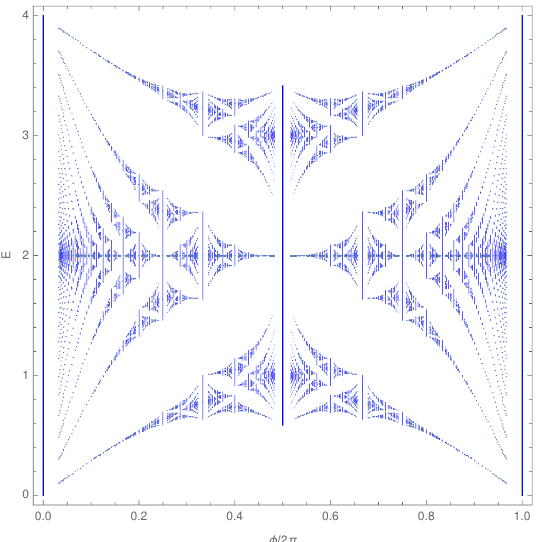
( N; (cid:30) ) with 0 (cid:20) k x ; k y (cid:20) 2 (cid:25)=Q x ;k y